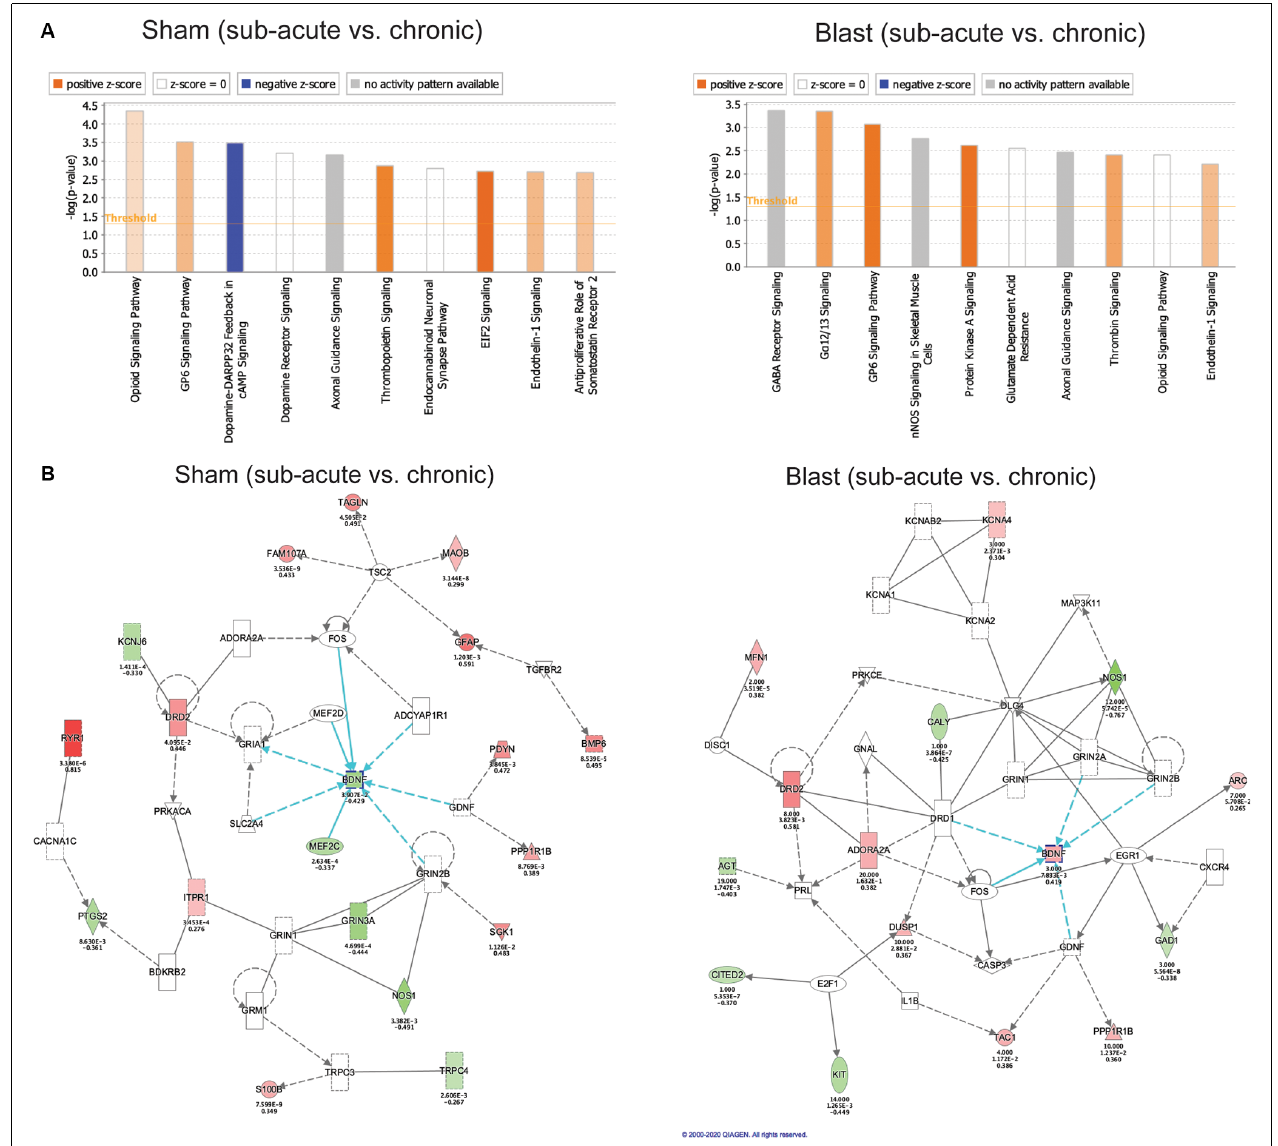
FIGURE 6 | Gene ontology enrichment using Ingenuity Pathway Analysis (IPA). (A) Top 10 gene categories. The y-axis gives the negative logarithm function of overlap p -value. Orange or blue bar represents a positive or negative activation z-score respectively, as calculated by IPA based on expected directionality of gene expression change within the gene category using the IPA knowledge base. White bars represent a z-score of 0 and gray bars signify that IPA was unable to calculate an activation z-score based on the unavailability of data in their knowledge base for that gene category. (B) Top gene network identified by IPA in the sham and blast cohorts comparing chronic vs. sub-acute time points. Green nodes within the network represent downregulated genes in our dataset and red nodes represent upregulated genes in our dataset. Nodes with no color represent IPA-generated genes using the IPA knowledge base. Blue arrows represent pathways interacting directly with Bdnf as a hub